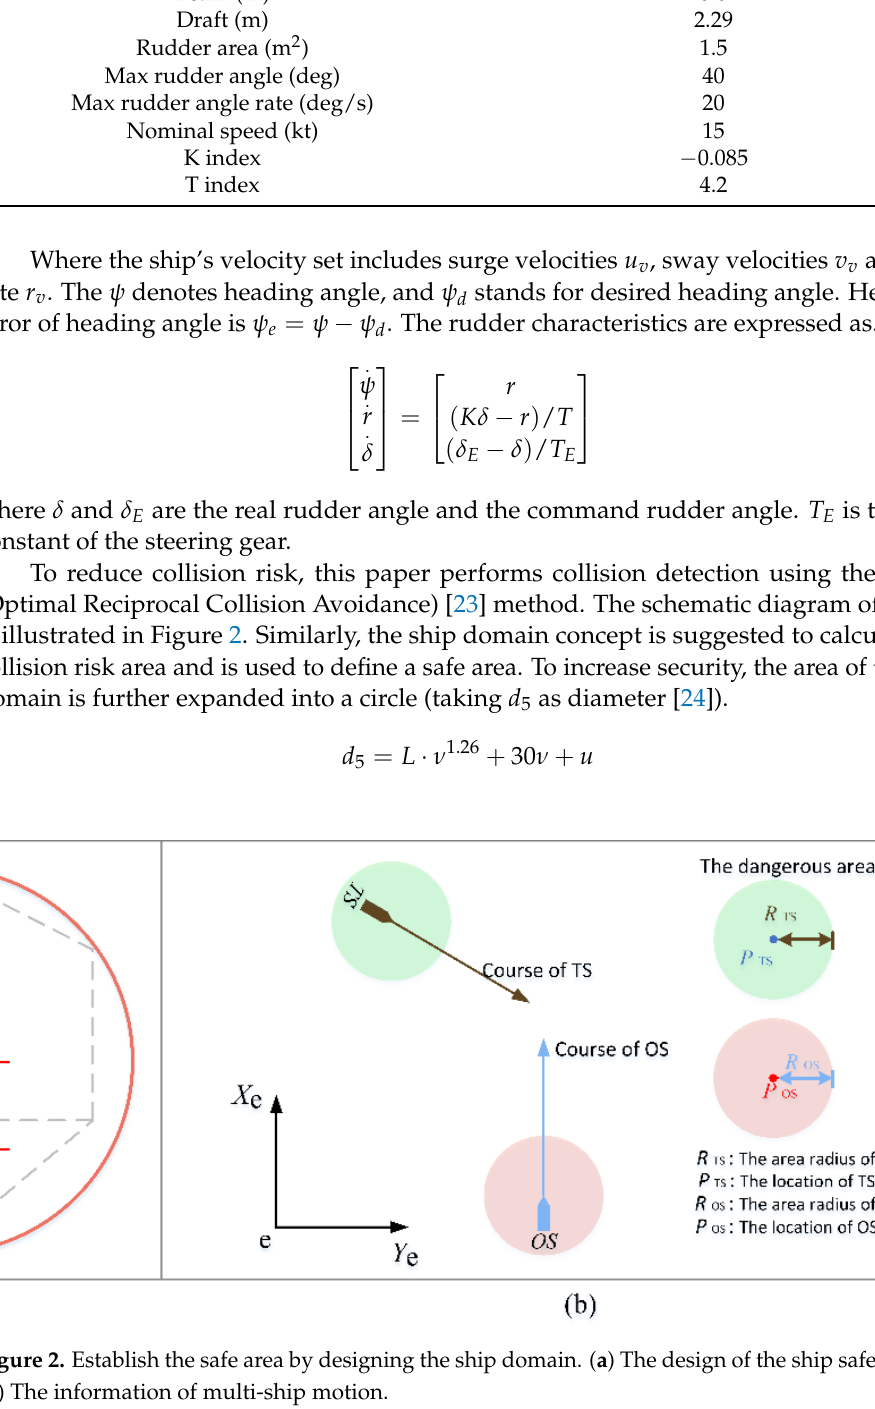
. Figure 3. Calculate the optimal velocity by ORCA: ( a ) When TS is stationary, the collision velocity is calculated; ( b ) When TS is moving, the collision velocity is calculated; ( c ) The geometric meaning of the vector u and n are expressed; ( d ) The geometric meaning of the optimal velocity is expressed.